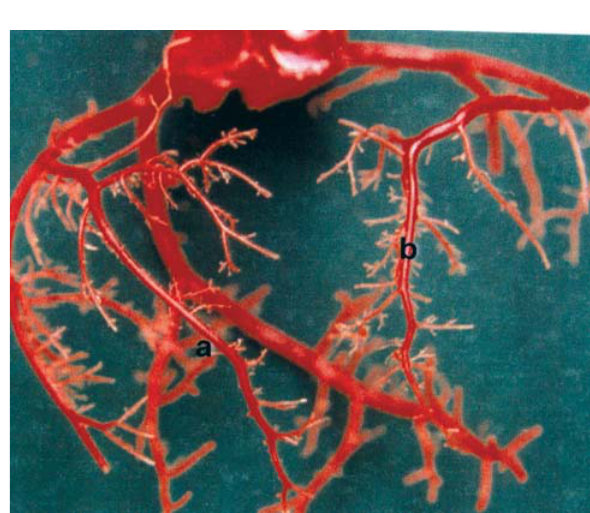
Fig. 4 - Dominância balanceada - a: ramo interventricular posterior da artéria coronária esquerda; b: ramo interventricular posterior da artéria coronária direita